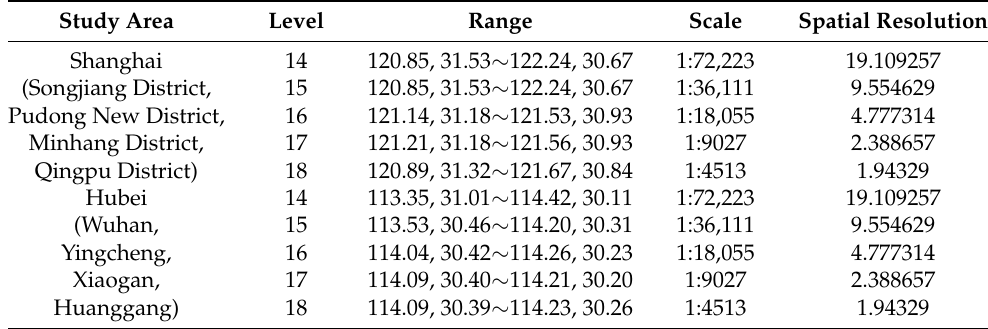
Table 2. Detailed information on the self-annotated RS-image-to-map dataset and study areas. Study Area Level Range Scale Spatial